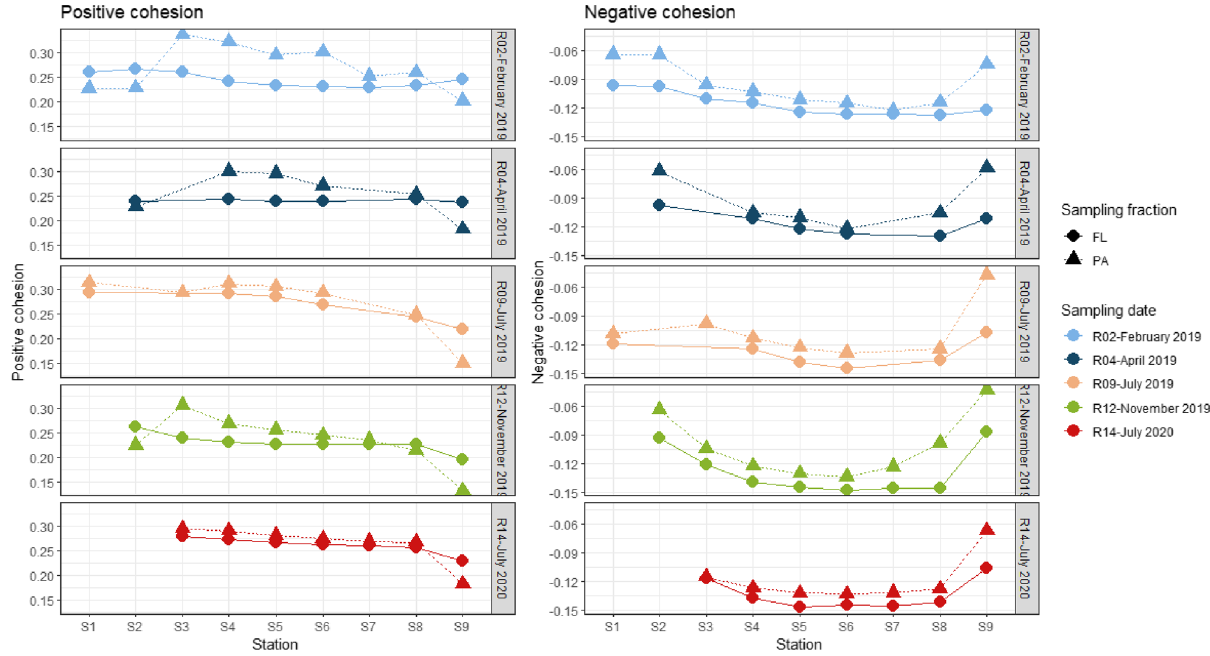
Figure 6. Positive and negative cohesion of FL and PA communities along the salinity gradient of the Aulne